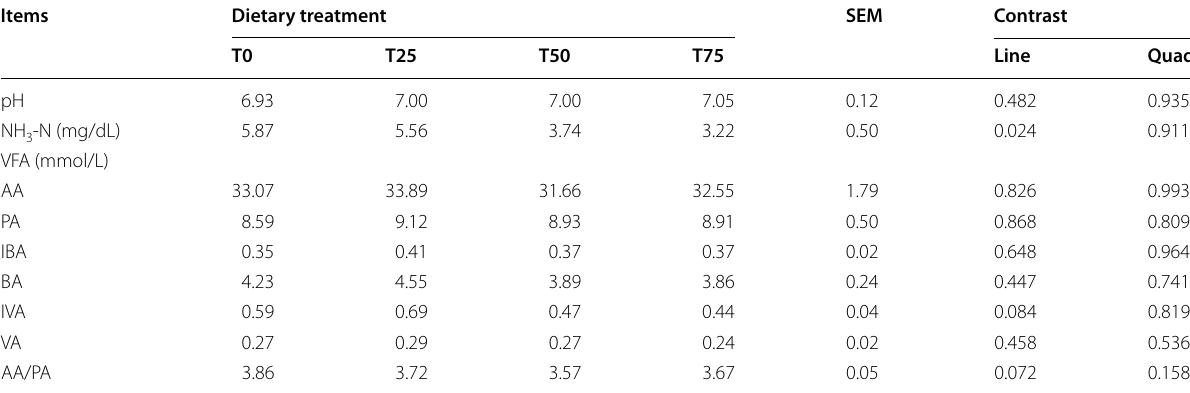
Table 3 Effects of BPS on rumen fermentation of Holstein